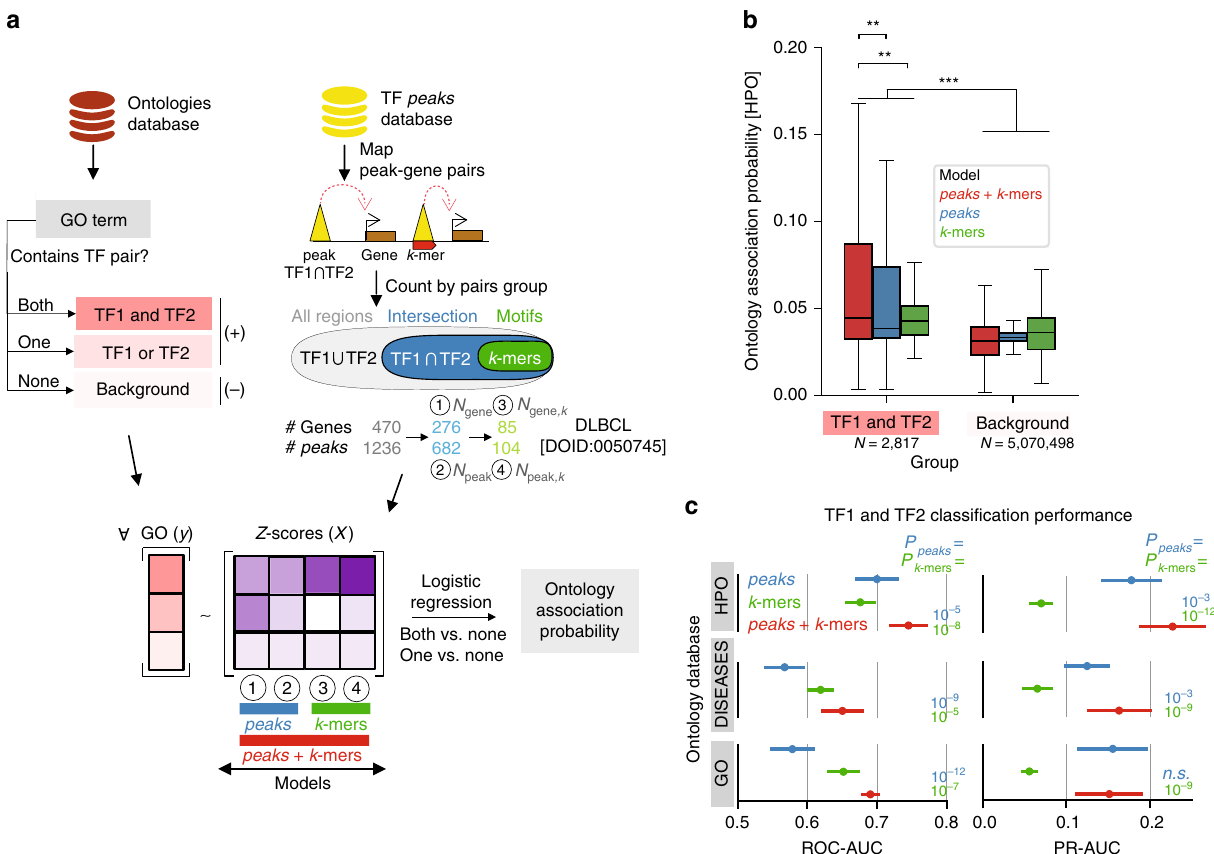
Fig. 5 Inference of TF-phenotype associations using TF-cooperative k-mers. a Scheme illustrating calculation of Ontology Association Probability values using TF – TF k -mers, ChIP-seq data and ontology databases. For each TF-pair and ontology combination, four metrics describing the numbers of genes and peaks proximal to the ontology-related genes are converted into Z -scores (see Methods section). From peaks assigned to for both TFs (TF1UTF2, gray oval), the sub-selection using the co-occupied peaks (TF1 ∩ TF2, blue oval; features 1 and 2) allows calculating N gene and N peak , and co-occupied peaks with TF – TF k -mers allow calculating N gene,k and N peak,k (green oval; Features 3 and 4). Ontologies are labeled by the presence of both TFs ( TF1 and TF2 ), only one ( TF1 or TF2 ), or none (background) in the ontology. Models with different combinations of features are tested ( peaks = 1 and 2 (blue); k-mers = 3 and 4 (green); peaks + k-mers = 1, 2, 3, and 4. (red)) (DLBCL = Diffuse large B-cell lymphoma. In example, genes are mapped from DOID:0050745 in DISEASES database 32 ). b Distributions of association probabilities for Human Phenotypes Ontology (HPO) terms for terms labeled as TF and TF2 vs. background terms are shown (Asterisk (*) indicate Wilcoxon rank-sum test p -values). c Classi fi cation task performances in the assessment of TF1 and TF2 vs. background terms in three ontology databases. ROC-AUC and PR-AUC indicate median areas under the ROC and Precision-Recall curves. Lines indicate 1.5 standard deviations above and below the median value. p -values are derived from 10-fold cross validation metrics comparisons between peaks + k-mers and color- matched approaches using an independent t -test, after Benjamini-Hochberg correction 56